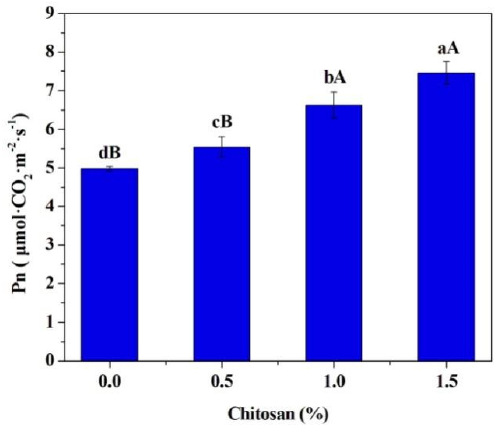
Figure 2. The effects of chitosan on the photosynthetic rate of leaves in R. roxburghii Values and error bars indicate the mean and SD of three replicates, respectively. Different small and capital letters indicate significant differences at 5% level ( p < 0.05) and 1% level ( p < 0.01), respectively. Table 2. The effects of chitosan on the chlorophyll content of leaves in R. roxburghii . Chitosan (%)